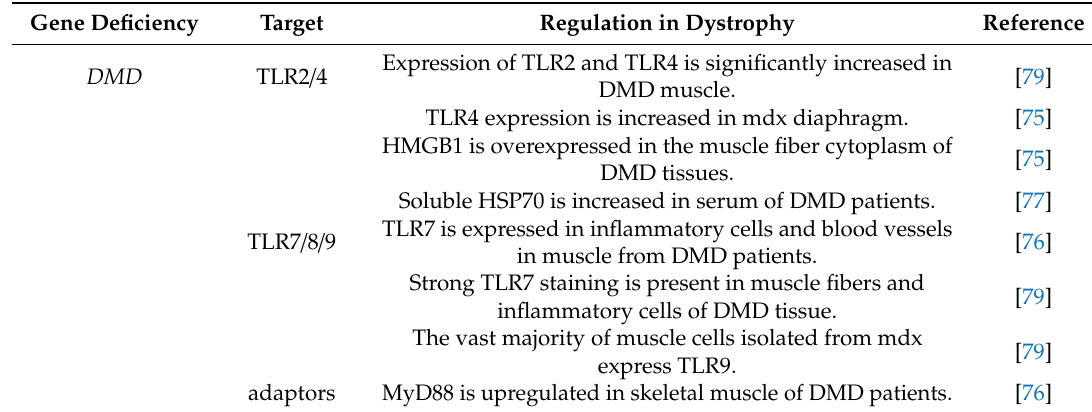
Table 2. TLR pathway alterations in muscular